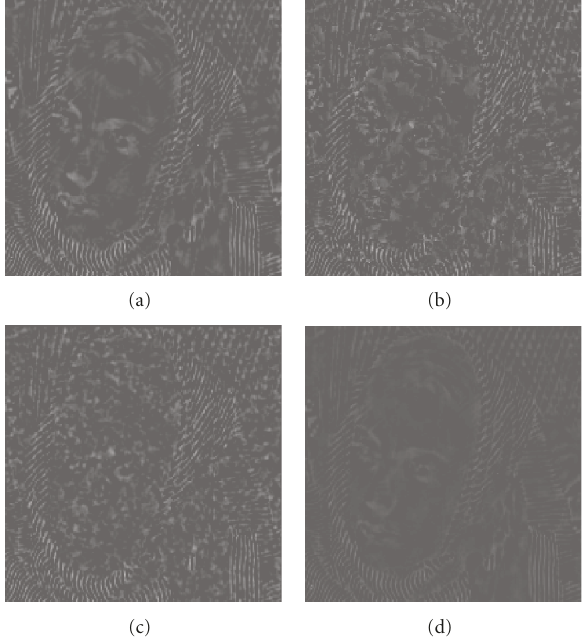
Figure 15: The di ff erence images between the original “Barbara” and restored “Barbara” images in Figure 14: (a) by the curvelet Shrinkage method; (b) by using the “TV” model; (c) by using the “TVGF” model; (d) by using our proposed